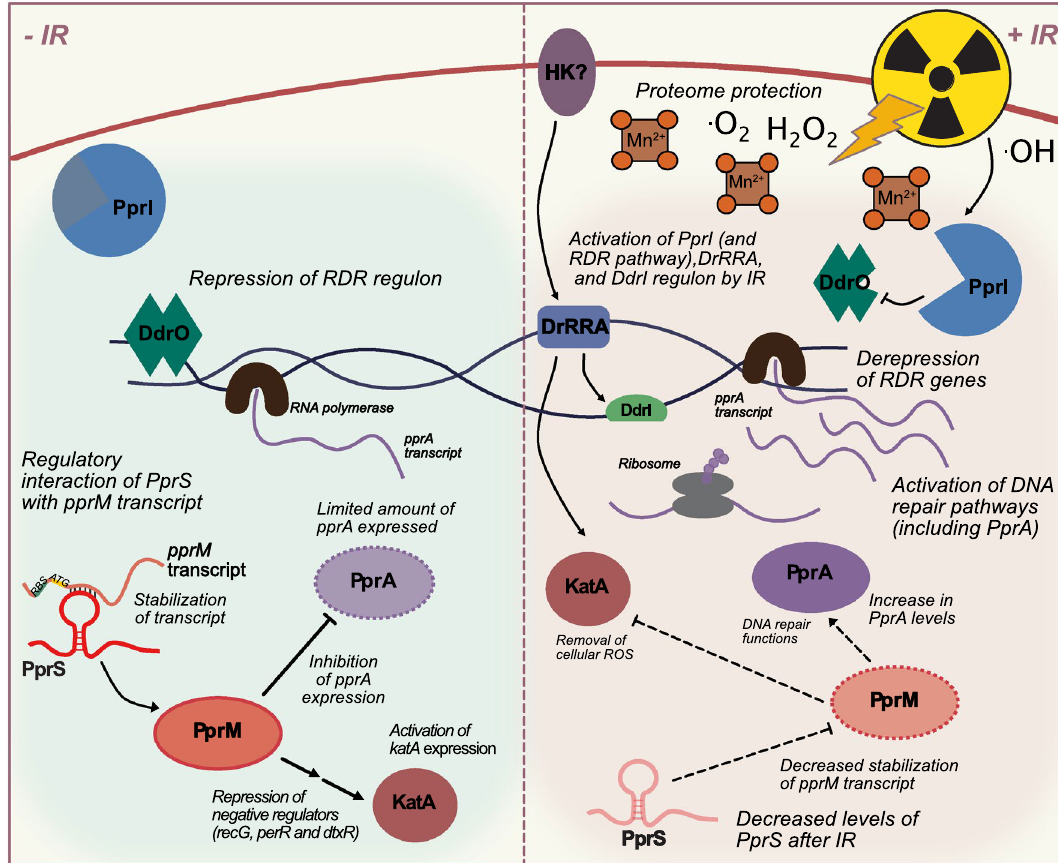
Figure 5. Model of PprS Regulatory Network in D. radiodurans. Three main transcriptional regulators have been identified in D. radiodurans : (1) a two-component system composed of the response regulator (DrRRA) and an unidentified histidine kinase (HK), (2) CRP regulator DdrI activated by DrRRA, and (3) the Radiation and Desiccation Response (RDR) containing the repressor protein DdrO and the IR-activated protease PprI. PprS is expressed during unirradiated conditions and binds to the pprM transcript within its CDS, stabilizing the transcript. PprM represses PprA expression to maintain low levels of PprA during unstressed conditions, and represses negative regulators of KatA. During recovery from IR, when PprA is required for DNA repair processes, transcriptional and translational machinery is protected by Mn-antioxidants and transcriptional PprA